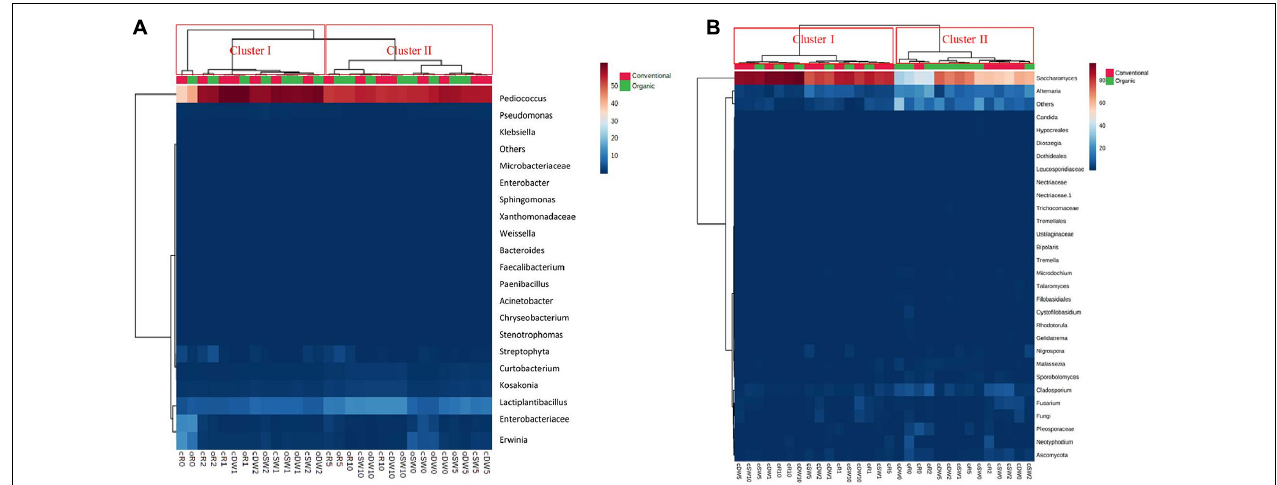
FIGURE 1 | Pseudo heatmap depicting bacterial (A) and yeast (B) diversity. Relative abundance (%) in DNA samples directly from conventional (c) and organic (o) soft wheat (SW), durum wheat (DW), and rye (R) doughs prior (cR0, oR0, cDW0, oDW0, cSW0, and oSW0) and after (cR1, oR1, cDW1, oDW1, cSW1, and oSW1) the first fermentation and after 1 (cR2, oR2, cDW2, oDW2, cSW2, and oSW2), 5 (cR5, oR5, cDW5, oDW5, cSW5, and oSW5), and 10 (cR10, oR10, cDW10, oDW10, cSW10, and oSW10) days of propagation. For bacteria, only operational taxonomic units (OTUs) with an incidence above 0.01% in at least one sample are shown. For yeasts, the 30 dominant genera identified are shown. The color key de?nes the percentage of OTU in the samples. Further details are included in the section “MATERIALS AND METHODS.” Bacterial and yeast genera, and samples are sorted based on Euclidean